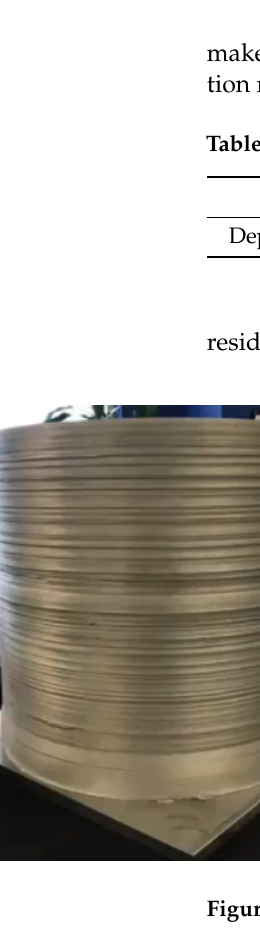
Figure 15. Temperature distribution pattern of AFSD model [60]. ( a ) Temperature distribution. ( b ) Temperature asymmetry at three feed rates.